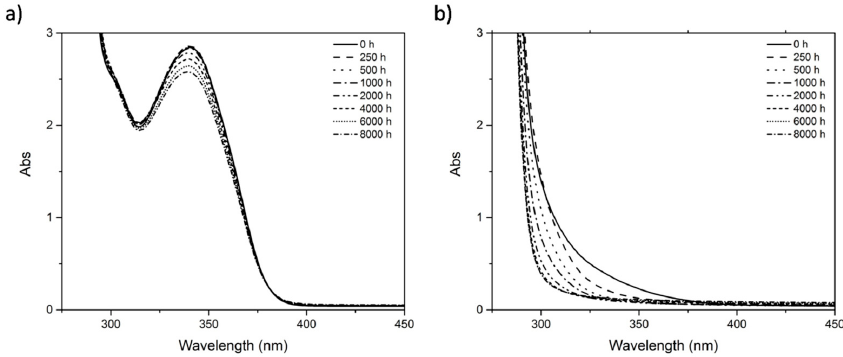
Figure 8. Absorption spectra of: ( a ) Reference sample TPA and ( b ) artist sample TPL, during artificial aging.